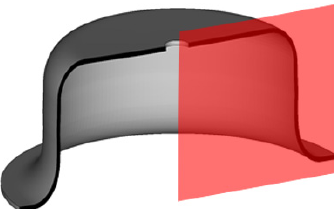
Figure 2. Half of the cross-section of the deep drawn cup used for the determination of the resulting hardness.